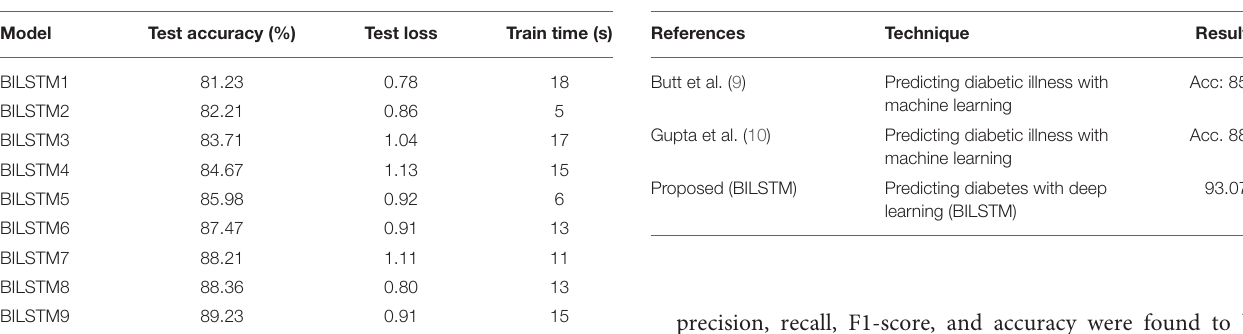
TABLE 7 | Comparison of the BILSTM model with other